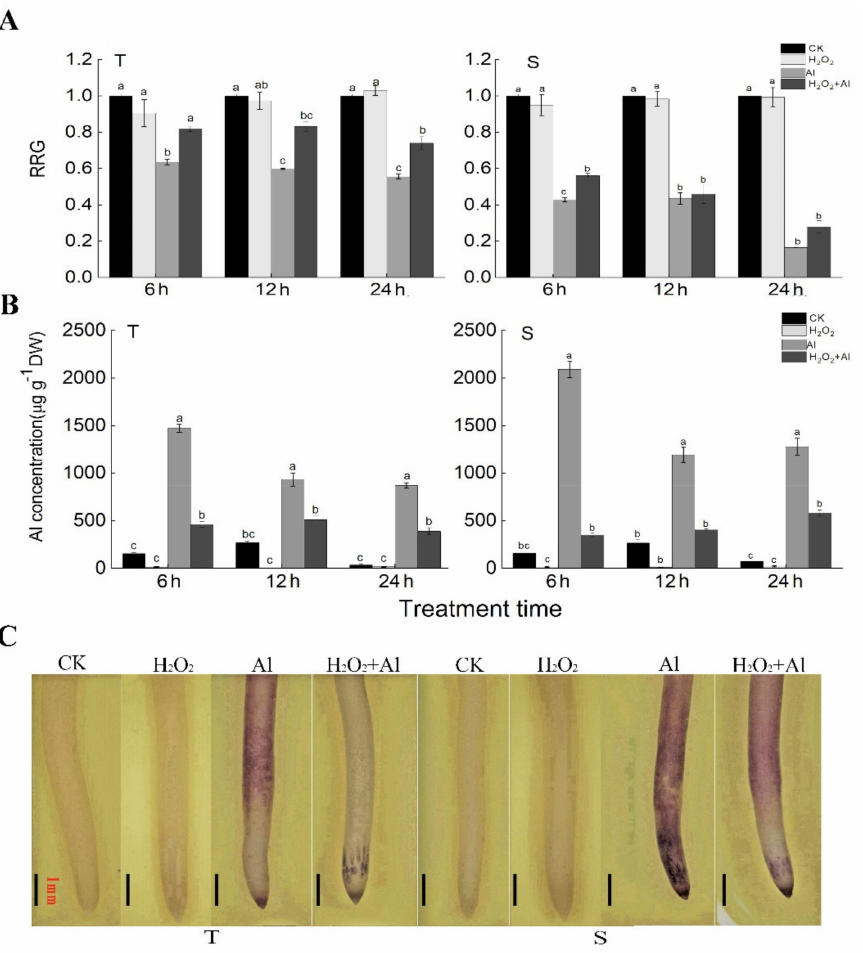
Figure 5. Effect of H 2 O 2 pretreatment on alleviating Al toxicity in soybean roots. ( A ) Relative root growth (RRG) of 4-d-old seedlings of soybean varieties T and S under control (CK) and different treatments. Means and standard errors were calculated from three biological replications, with six plants per replication. Data with the same letters above bars indicate no significant differences at a significance level of 0.05 (by Duncan’s new multiple range test) for each time point. ( B ) Al concentration in the roots of T and S at 6, 12, and 24 h after different treatments and CK. Means and standard errors were calculated from two biological replications, with over 50 plants per replication. DW: dry weight. Data with the same letters above bars indicate no significant differences at a significance level of 0.05 (by Duncan’s new multiple range test) for each time point. ( C ) The root tips of T and S under CK and different treatments for 24 h, stained by hematoxylin. The experiments were repeated three times. Scale bars = 1 mm. CK: 0 µ M AlCl 3 , pH = 4.3. H 2 O 2 : 100 µ M H 2 O 2 + 0 µ M AlCl 3 , pH = 4.3. Al: 25 µ M AlCl 3 , pH = 4.3. H 2 O 2 +Al: 100 µ M H 2 O 2 pretreatment for 6 h then subjected to Al treatment for 6, 12, and 24